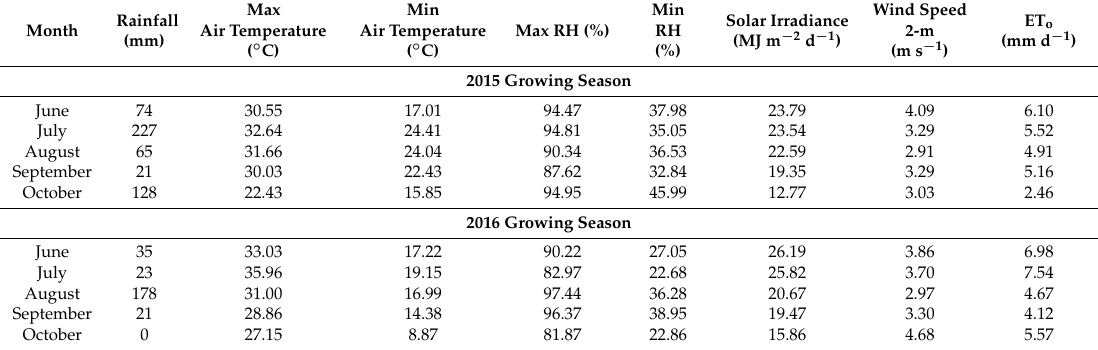
Table 1. Climatic data for the 2015 and 2016 growing seasons at Bushland, TX, USA.